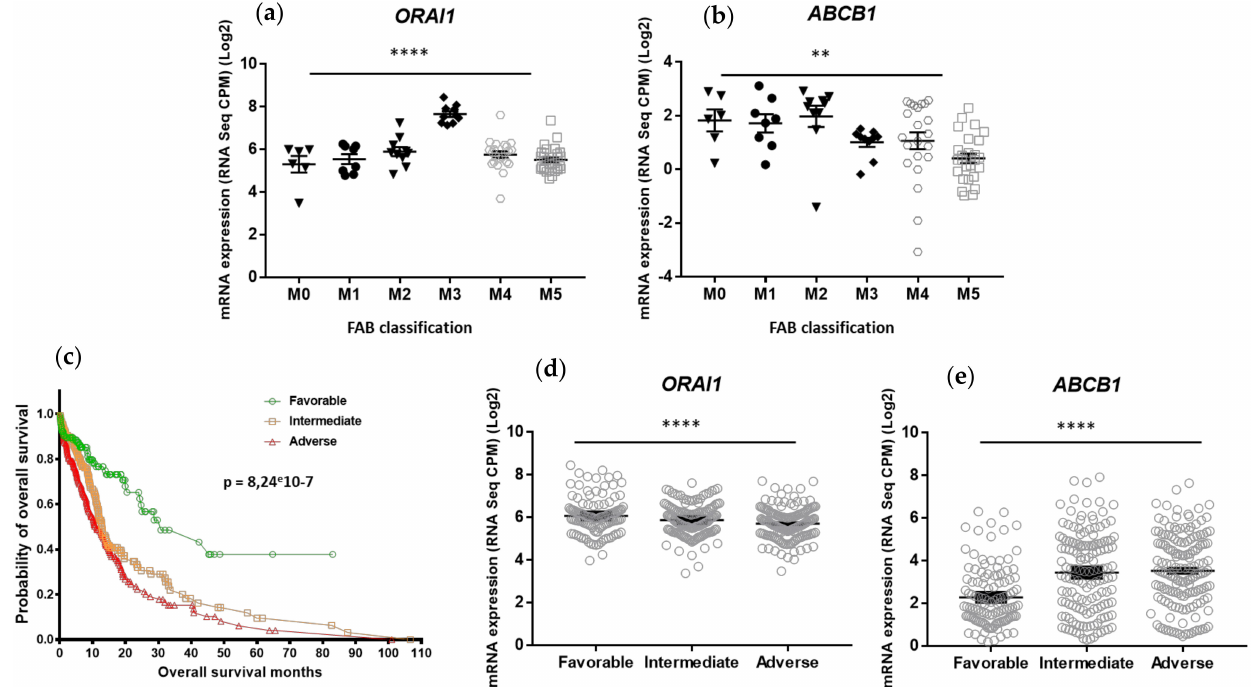
Figure 2. Differential expression patterns of ORAI1 and ABCB1 in AML primary cells isolated from patients at the time of disease diagnosis, according to the FAB classification and ELN 2017 risk stratification. ( a – e ) RNA-seq data were generated by Tyner et al. [12] from samples derived from patients with AML at disease diagnosis. RNA-Seq data were obtained from public domain AML datasets (https://www.cbioportal.org, accessed on 15 March 2022). Data were extracted as described by [13,14] for ORAI1 and ABCB1 expression in AML primary cells according to the FAB classification ( a , b ). Overall survival of 439 adult patients with de novo AML according to ELN2017 risk stratification (favorable, intermediate, adverse). The p value is based on the log rank test. ( c ). Data were extracted for ORAI1 ( d ) and ABCB1 ( e ) expression according to ELN2017 risk stratification. Normalized expression values are presented as CPM; p values are from one-way ANOVA tests comparing the different means (** p < 0.01; **** p <